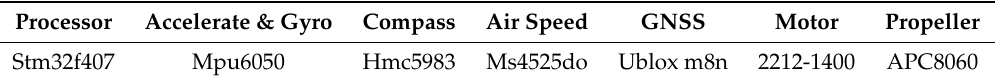
Figure 15. The connection of the small autopilot and its electronic equipment. Table 5. Sensors of the autopilot and